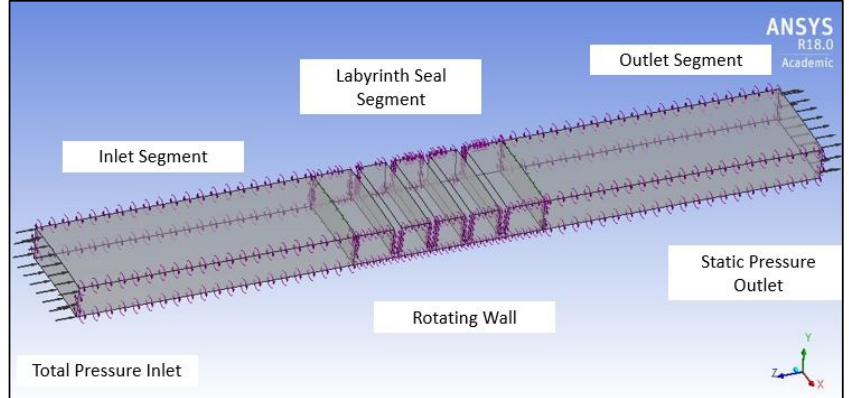
Figure 4. Rotor teeth boundary conditions.